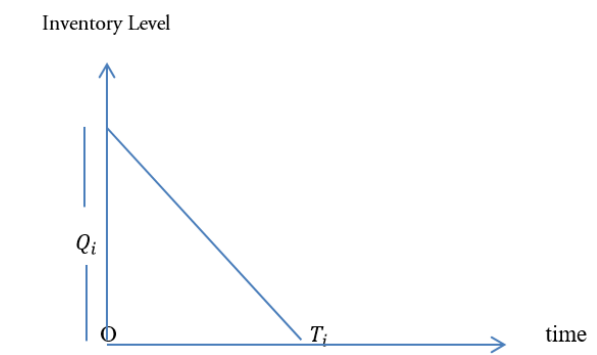
Fig. 1. Inventory level for the i th